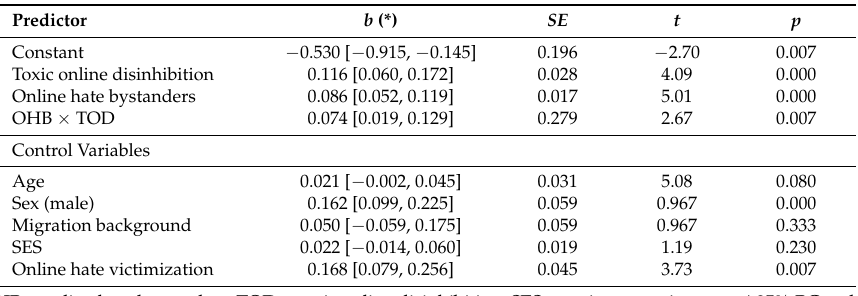
Table 2. Coefficients of the model predicting online hate perpetration.